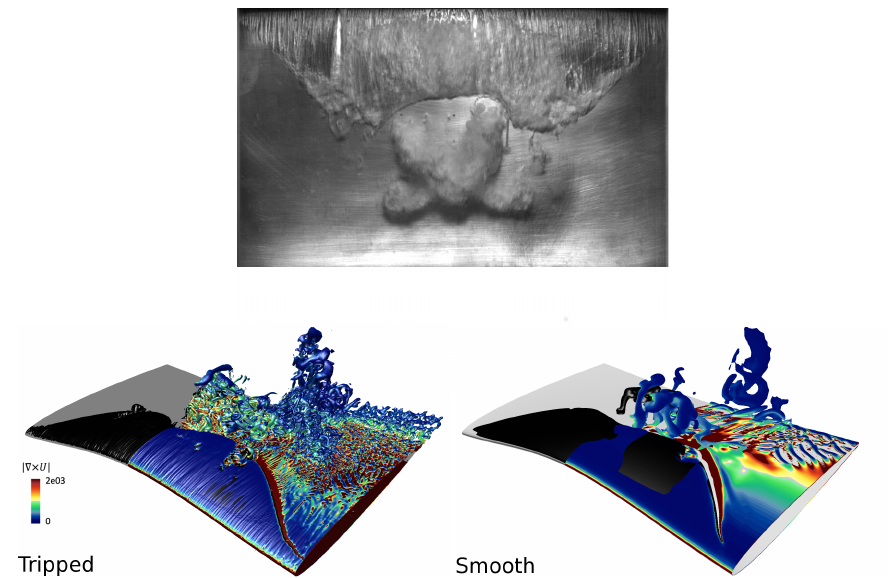
Figure 10. Isometric view of the numerical results of Figure